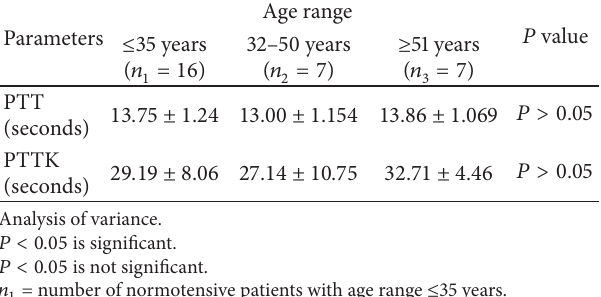
Table 4: Comparison of the prothrombin time test (PTT) and partial thromboplastin time test kaolin (PTTK) across ages of normotensive patients attending the University of Calabar Teaching Hospital. Parameters